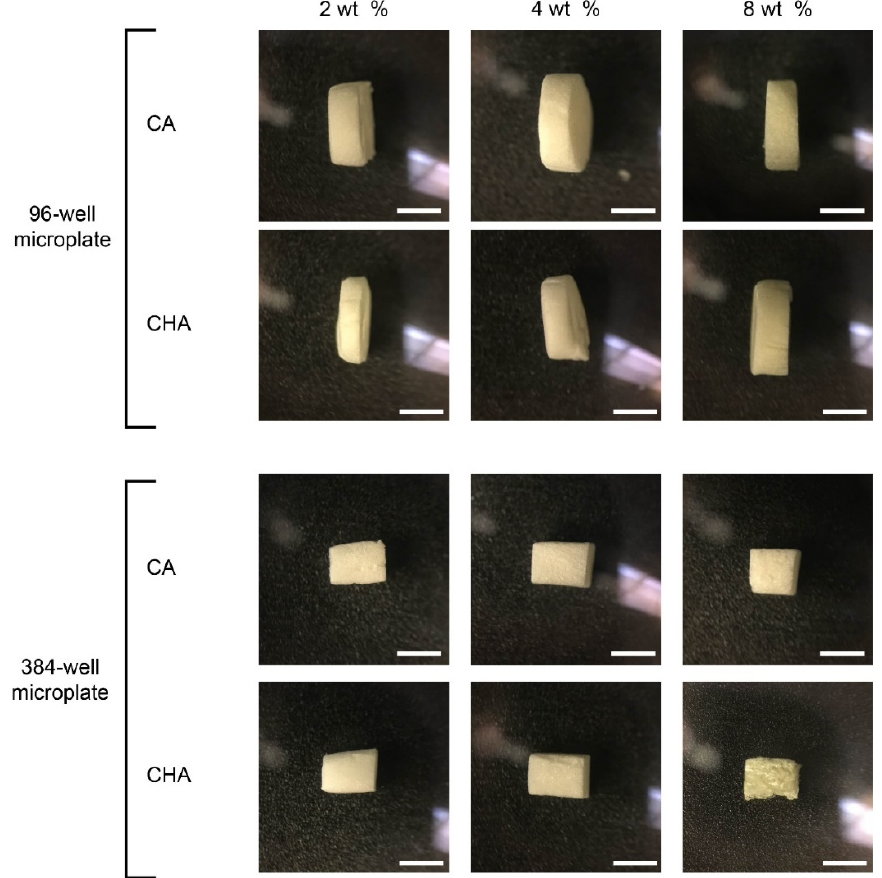
Figure 8. Photographs of scaffold sections cut from bulk scaffolds removed from both 96 ‐ and 384 ‐ well plates. Side view images of CA and CHA scaffolds of 2, 4, and 8 wt % polymer cast in 96 ‐ and 384 ‐ well plates. Scale bars represent 2 mm.